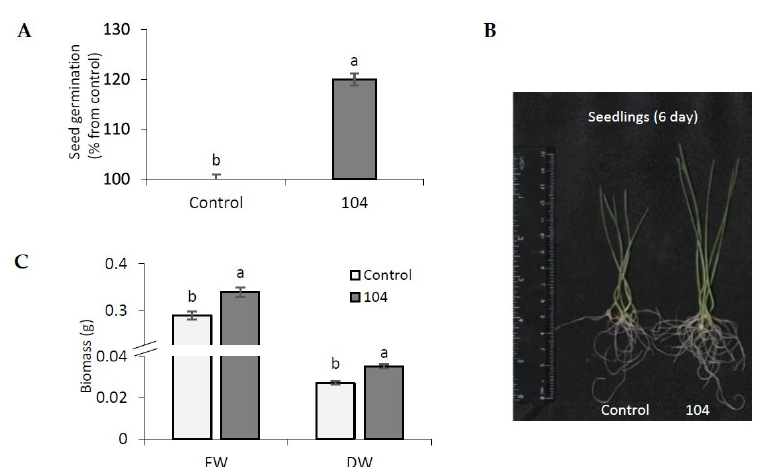
Figure 1. E ff ect of Bacillus subtilis 10–4 (104) on the percentage of seed germination (3 days after sowing) ( A ), length of seedlings (roots and shoots) ( B ), and fresh (FW) and dry biomass (DW) accumulation ( C ) (6 days after sowing) under normal growth conditions. The error bars show the average of three replicates ± standard error of the mean (SEM) ( n = 50). Di ff erent letters indicate a significant di ff erence between the average values for p < 0.05. Table 1. Some plant growth-promoting (PGP) traits of tested bacteria B. subtilis 10–4. Bacteria IAA (mg L −1